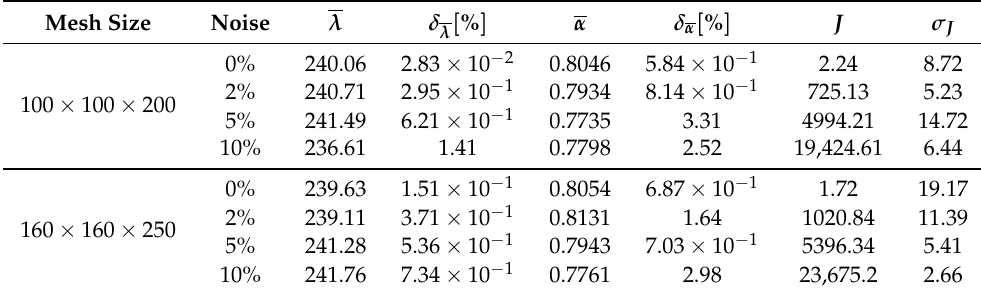
Table 1. Results of calculations in case of ACO algorithm. λ —reconstructed value of thermal conductivity coefficient; α —reconstructed value of x -direction derivative order; δ —the relative error of reconstruction; J —the value of objective function; σ —standard deviation of objective